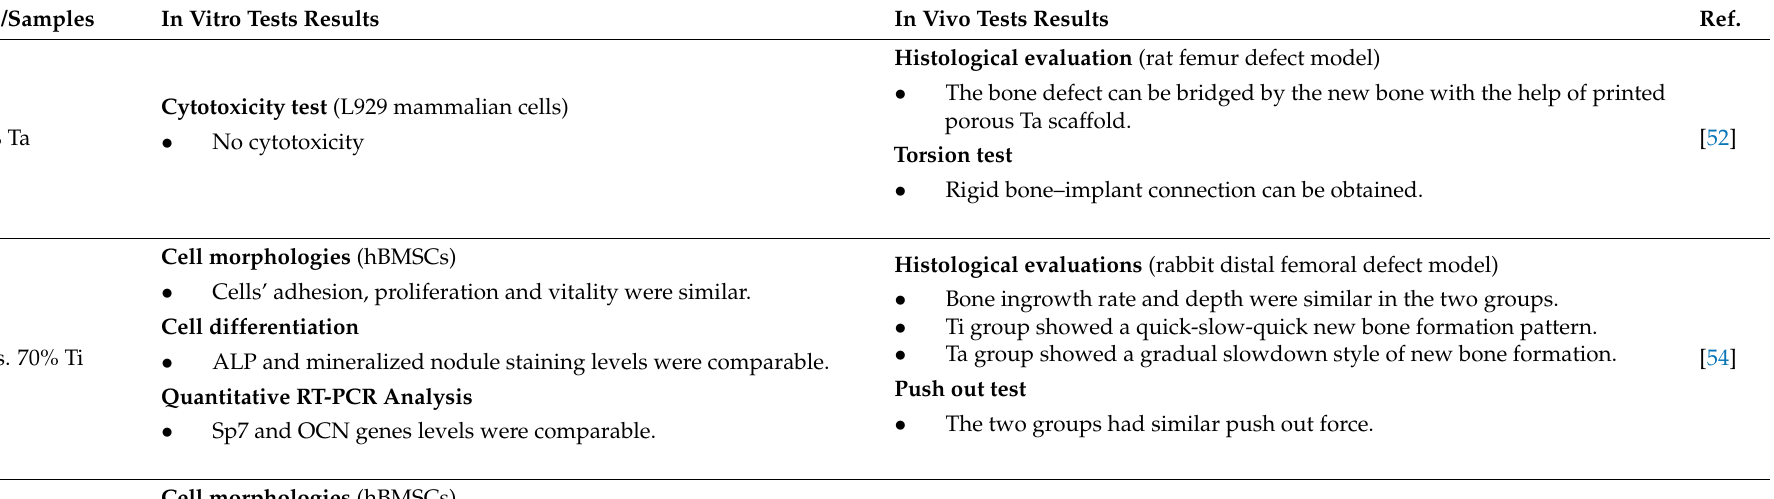
Table 2. The biological properties of additive manufactured porous Ta